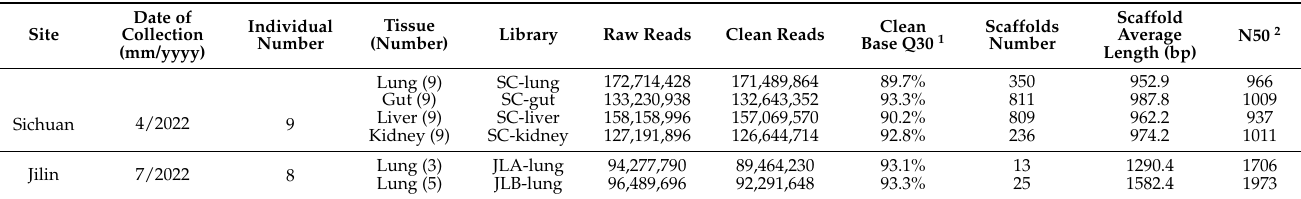
Table 1. Information on the sample libraries and sequencing data results.